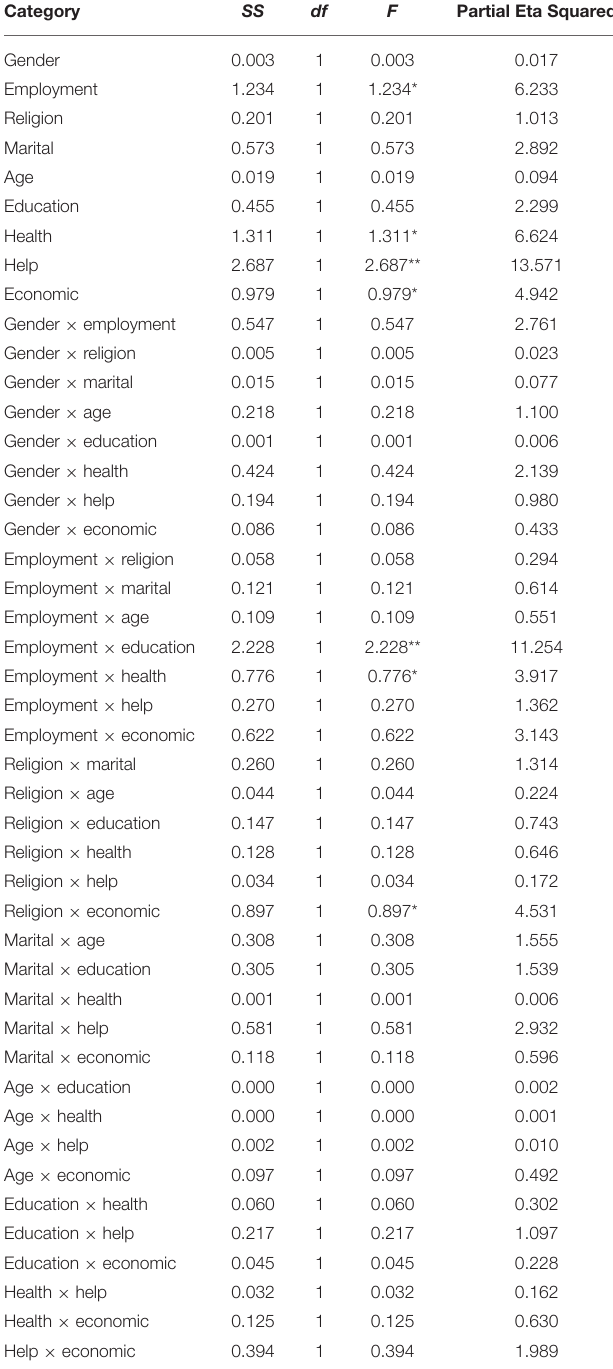
TABLE 3 | Main and interaction effect of socio-demographic